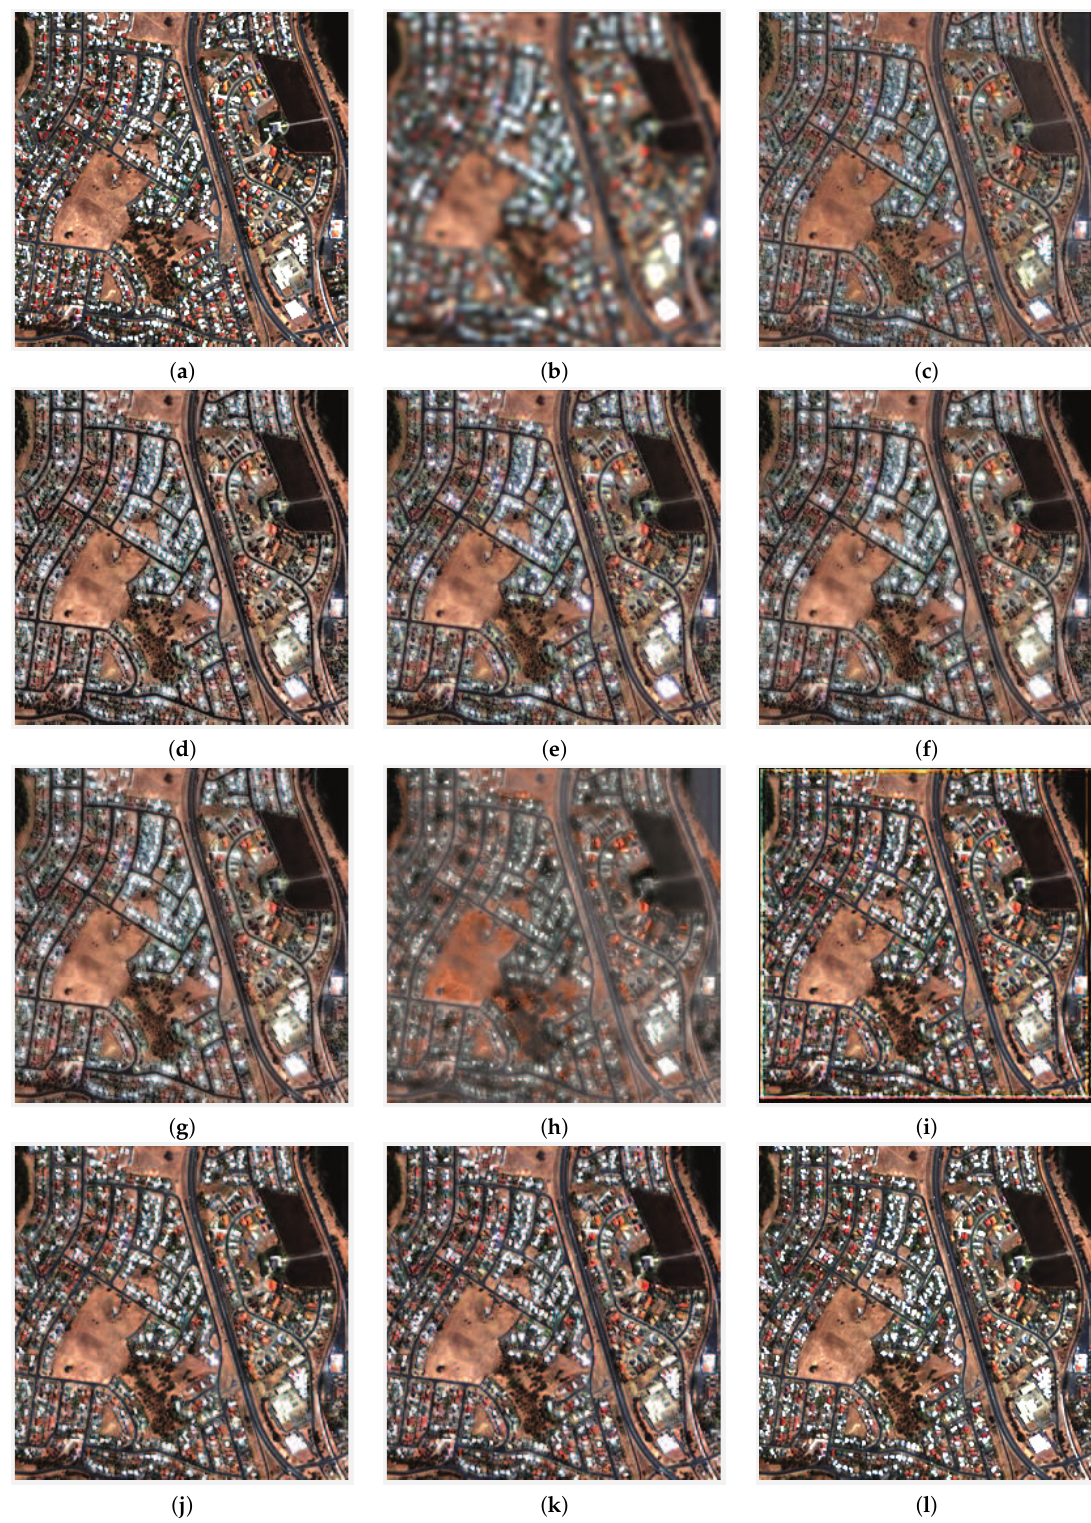
Figure 5. Pansharpening results for the IKONOS dataset: ( a ) ground truth; ( b ) EXP; ( c ) PCA; ( d ) GSA; ( e ) PRACS; ( f ) ATWT; ( g ) MTF-GLP-HPM; ( h ) CNMF; ( i ) PNN; ( j ) DRPNN; ( k ) DiCNN1; and ( l )